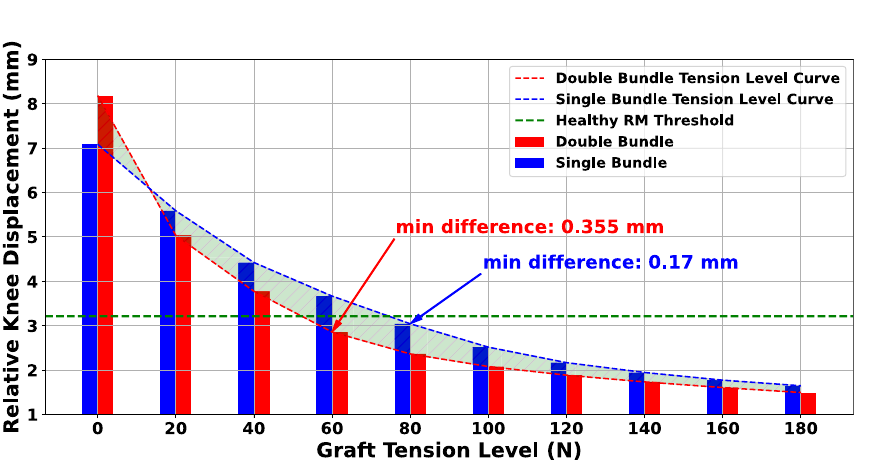
Figure 10. Results for comparing the SB and DB techniques. The “difference” term refers to the absolute difference in relative knee displacement translation between the FE model and the RM. Although the DB method appears to be superior in restraining knee laxity, the margin between the two methods is not